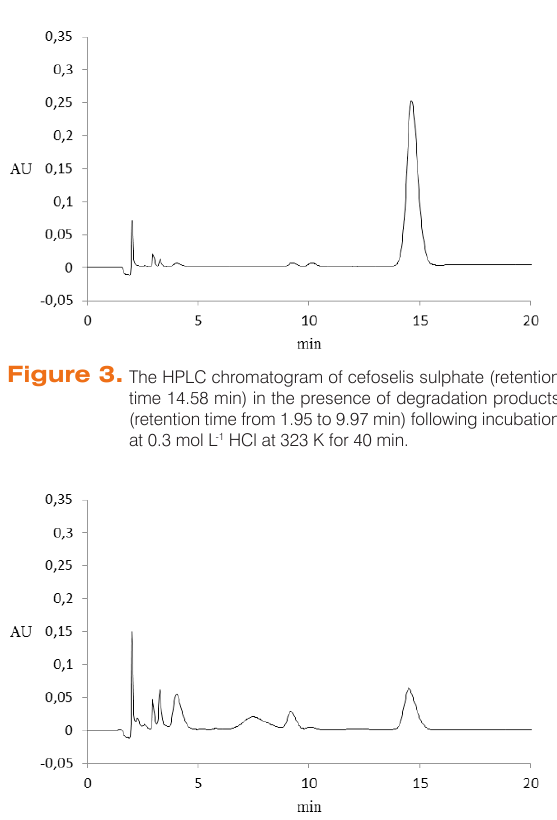
Figure 4. The HPLC chromatogram of cefoselis sulphate (retention time 14.58 min) in the presence of degradation products (retention time from 1.95 to 9.97 min) following incubation at 0.1 mol L -1 NaOH at 313 K for 7